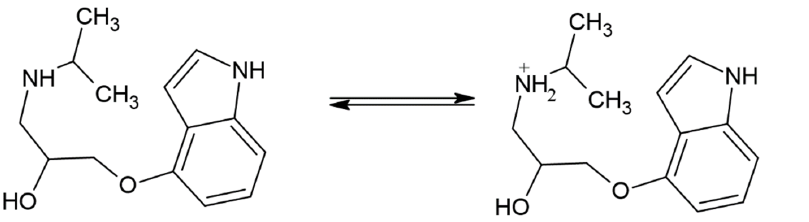
Figure 7. Optimized structure of pindolol used for the calculation of p K a value. The optimized structure presented in Figure 7 was used to calculate the p K a value using an empirical approach. The experimental p K a value of pindolol was 9.49 [53]. The calculations gave a result of 9.39, which shows excellent agreement between